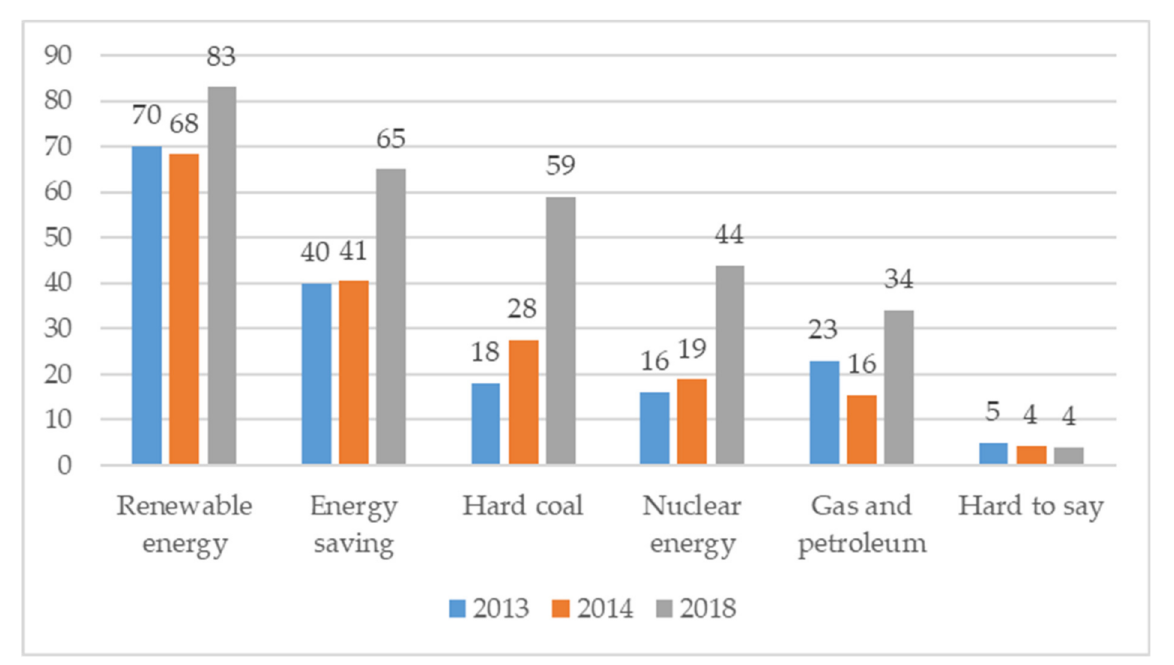
Figure 6. Type of energy that respondents believe should be developed in Poland in the near future (respondents could indicate two answers). Source: developed by the authors, based on Reference